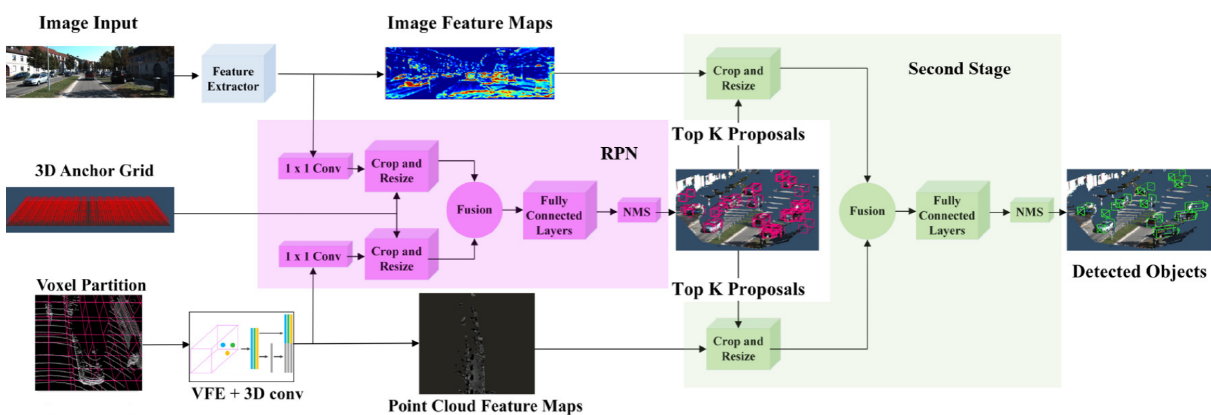
Figure 22. Aggregate view object detection [120] network pipeline for 3D object detection in the context of autonomous